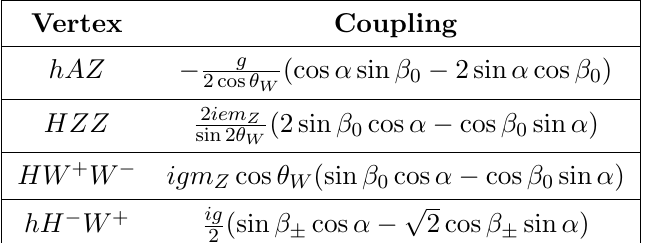
Table 1 . Three-point vertices related to the determination of (cid:21) 4 ; 5 . (cid:21) 5 is determined through mass splitting, (cid:21) 4 is determined through the mixing angle sin (cid:11) , which is sensitive to (cid:21) 45 .